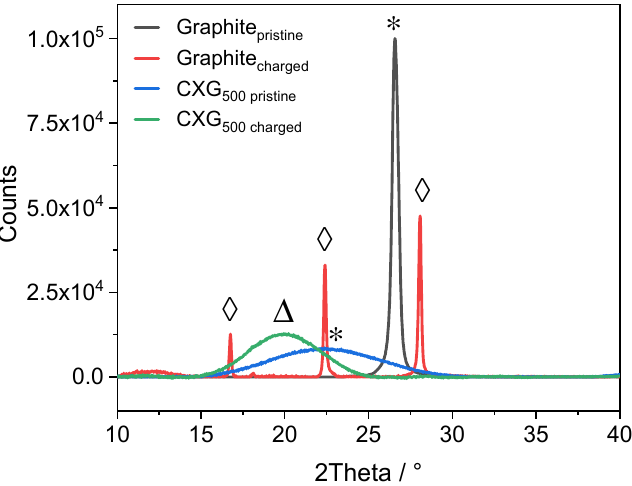
Figure 10. Ex situ XRD analysis of pristine and fully charged natural graphite and CXG 500 electrodes. Peaks marked with (*) indicate position of (002) peak in both pristine electrodes. The peak marked with ( ∆ ) is assumed to be associated with the (002) peak shift due to intercalated species in CXG 500 . Peaks indexed with ( ♦ ) are related to GIC-induced peaks in natural graphite sample. Table 1. Correlation of intercalation stage (n) and theoretical d (n+2) /d (n+1) ratio according to [83,87]. Stage